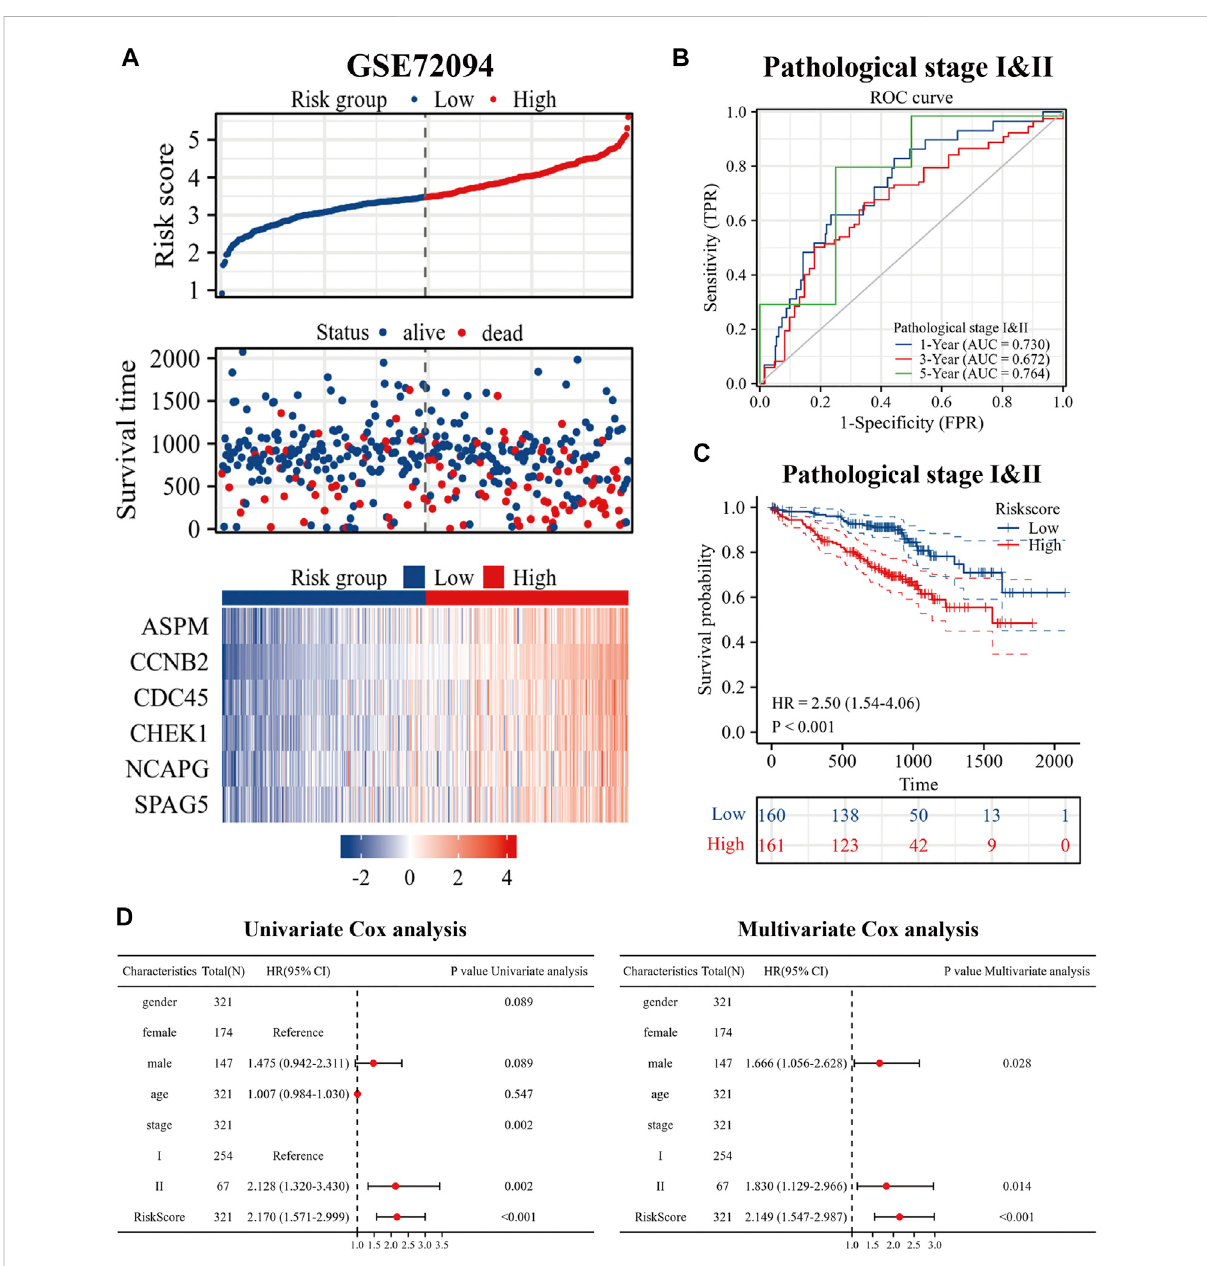
FIGURE 8 Validationofrisksignature. (A) Riskfactordiagramofes-LUADpatientsinGSE72094dataset; (B) ROCcurveforGSE72094dataset; (C) KMcurve in validation group based on risk score. (D) Univariate and Multivariate Cox analysis of risk score and clinical factors. ROC: receiver operating characteristic; KM: